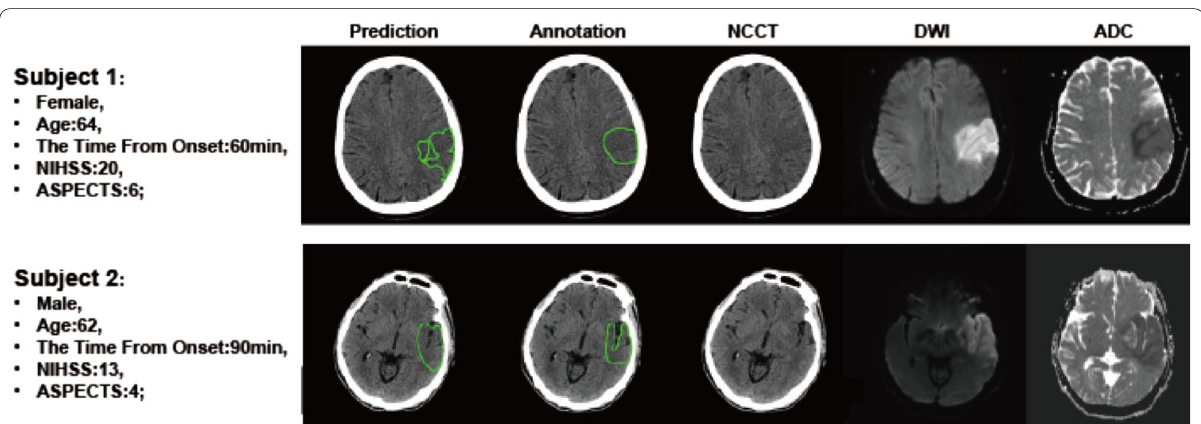
Fig. 5 Visualization cases of the DL-based model. The prediction is the model segmentation output and the annotation denotes the ground truth defined by the expert radiologists. The dice, precision and recall were 0.817, 1.0 and 0.690 for subject 1 and 0.670, 1.0 and 0.502 for subject 2,